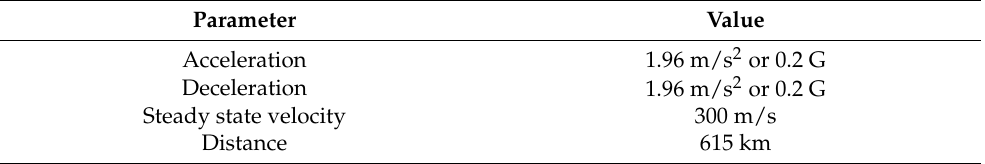
Table 1. General parameters for the design of the Hyperloop system [2].